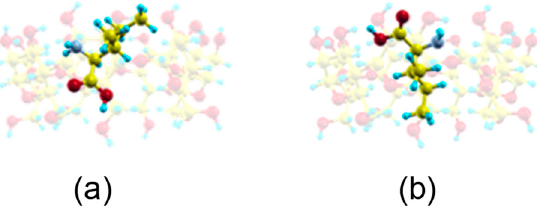
Figure 6. The most probable inclusion complex configurations for Ile enantiomers in vacuo deduced from the MD simulation, in which the carboxylic end of the amino acid is pointing towards ( a ) the narrow rim of β –CD; ( b ) the wide rim of β –CD. The guest molecule has been superimposed for clarity.